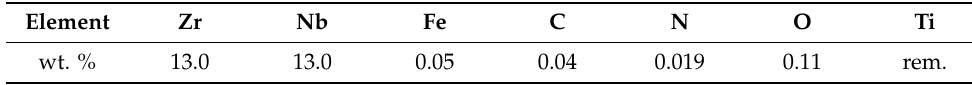
Table 1. The chemical composition of the Ti13Nb13Zr alloy, wt. %.